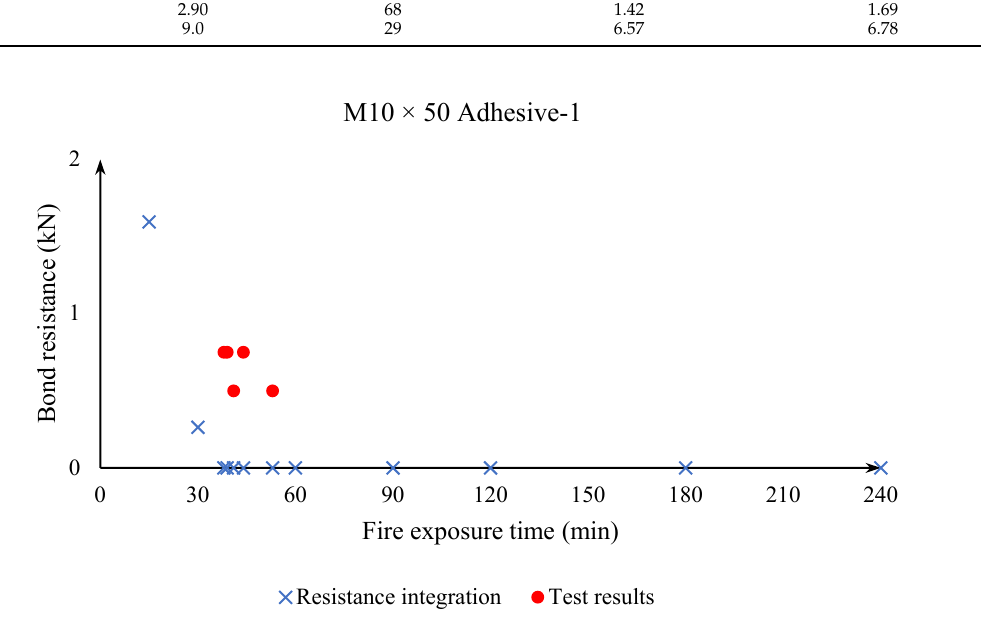
Figure 11. Fire resistance of M10 × 50 bonded anchor using Adhesive-1. Table 1 summarizes the data of this study: fire test data (applied load and pull-out failure time under fire conditions), Pinoteau’s RIM results considering the bond stress vs. temperature curve with/without considering temperatures beyond T max